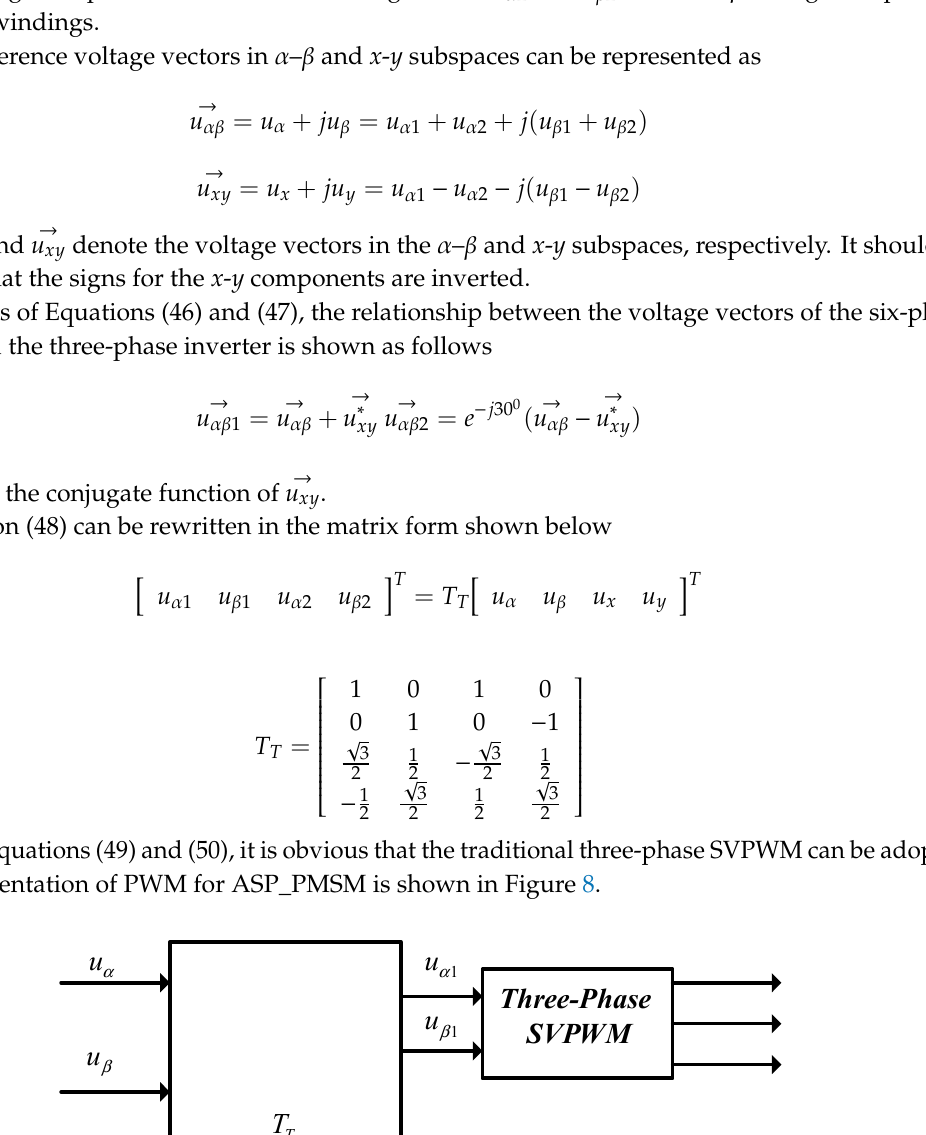
Figure 9. Control diagram of a control scheme for ASP-PMSM.